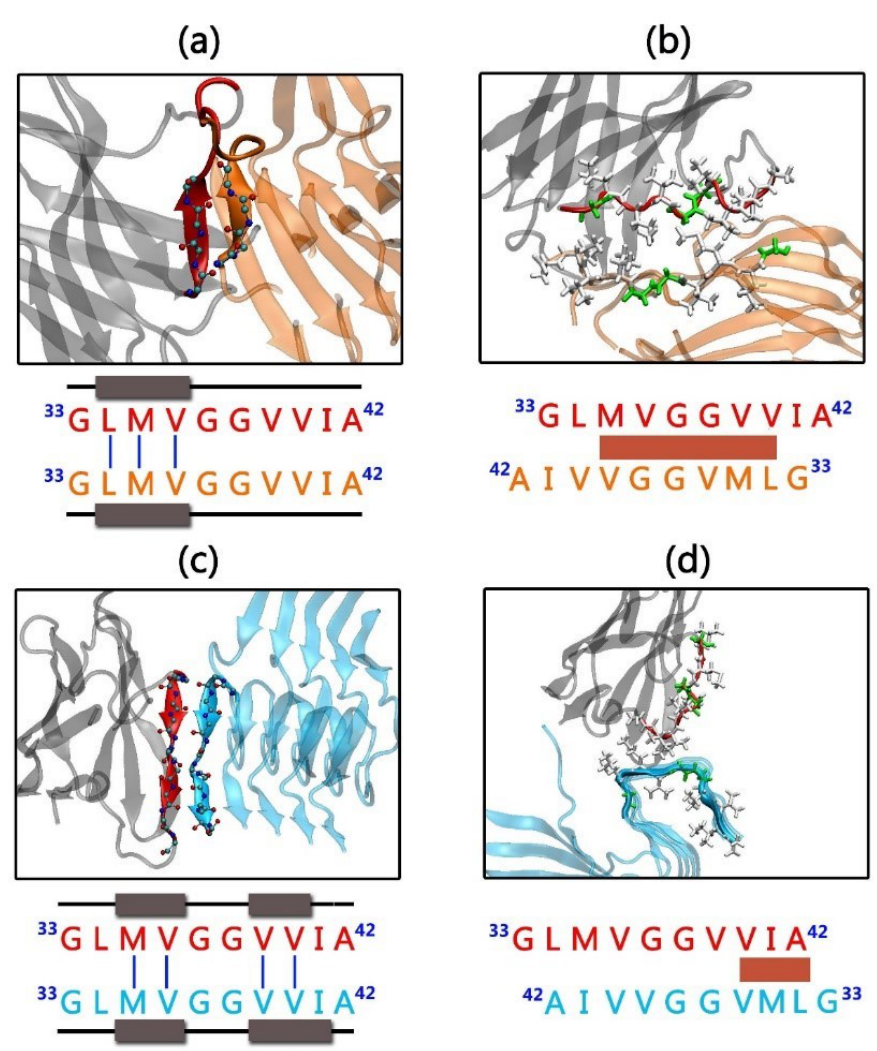
Figure 5. Simulation snapshots suggest that the gammabody CDR3 loop can form stable β -sheet interaction with A β amyloid, and binding on sidechain surface is also possible. Interfacial interactions of ( a ) 2U_Backbone; ( b ) 2U_SideChain; ( c ) 3S_Backbone; and ( d ) 3S_SideChain gammabody-A β complexes, with the interfacial interactions highlighted. For easy comparison, the residue numbers in grafted A β motif in gammabody are set as their original residue number in A β peptide. Gammabody residues are in red